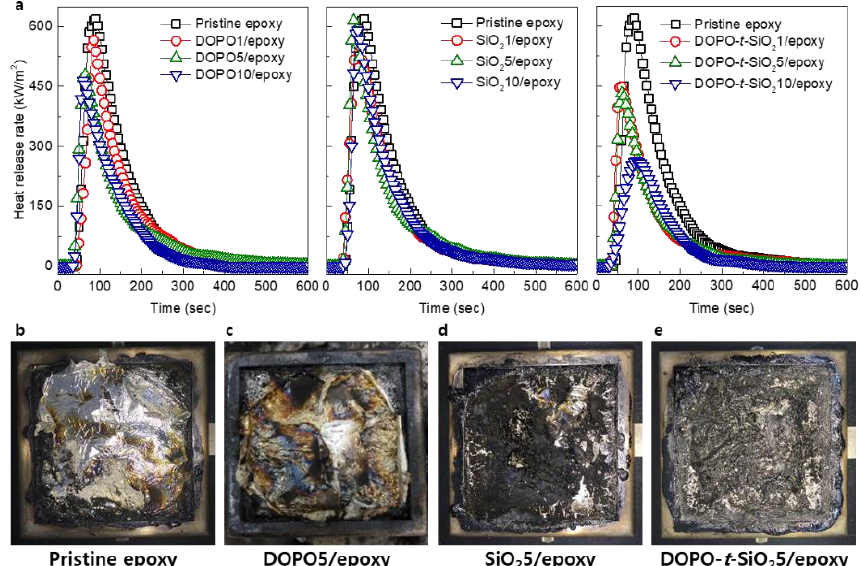
Figure 4. ( a ) Heat release rate measured using cone calorimeter of pristine epoxy, DOPO / epoxy, SiO 2 / epoxy and DOPO- t -SiO 2 / epoxy nanocomposites with the content of additives, respectively. Photographs of ( b ) pristine epoxy, ( c ) DOPO5 / epoxy, ( d ) SiO 2 5 / epoxy and ( e ) DOPO- t -SiO 2 5 / epoxy nanocomposites after cone calorimeter test, respectively. Table 1. Data obtained from cone calorimeter test of pristine epoxy, DOPO / epoxy, SiO 2 / epoxy and DOPO- t -SiO 2 / epoxy nanocomposites, respectively.